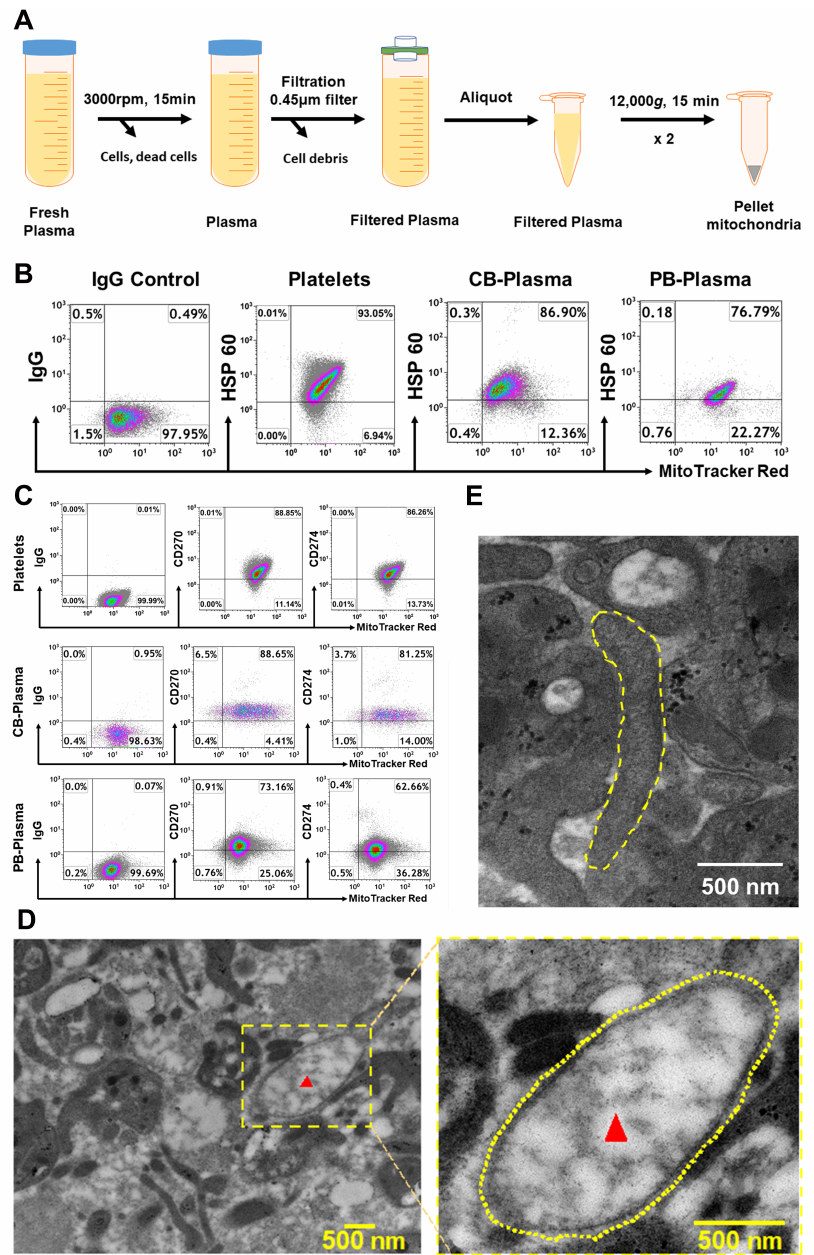
Figure 1. Characterization of mitochondria in human blood. ( A ) Outline the protocol for an isolation of mitochondria from plasma. ( B ) Flow cytometry data show the plasma-derived mitochondria positive for specific mitochondrial markers (MitoTracker Deep Red) and heat shock protein (HSP) 60 from the plasma of human cord blood (CB, N = 4) and adult peripheral blood (PB, N = 4). Mitochondria isolated from the plasma of peripheral blood ( N = 4) served as positive control. ( C ) Expression of immune tolerance-associated markers CD270 and CD274 on human CB ( N = 8) and PB ( N = 9) plasma-derived mitochondria respectively. Mitochondria isolated from peripheral blood-derived platelets served as positive control. Isotype-matched IgGs served as negative control. ( D ) Electron microscopy demonstrating the free mitochondria (red arrow, left) in the plasma of adult human blood, with a high magnification (yellow dashed circle, right). ( E ) Electron microscopy show a free elongated mitochondrion (yellow dashed circle) in adult human blood